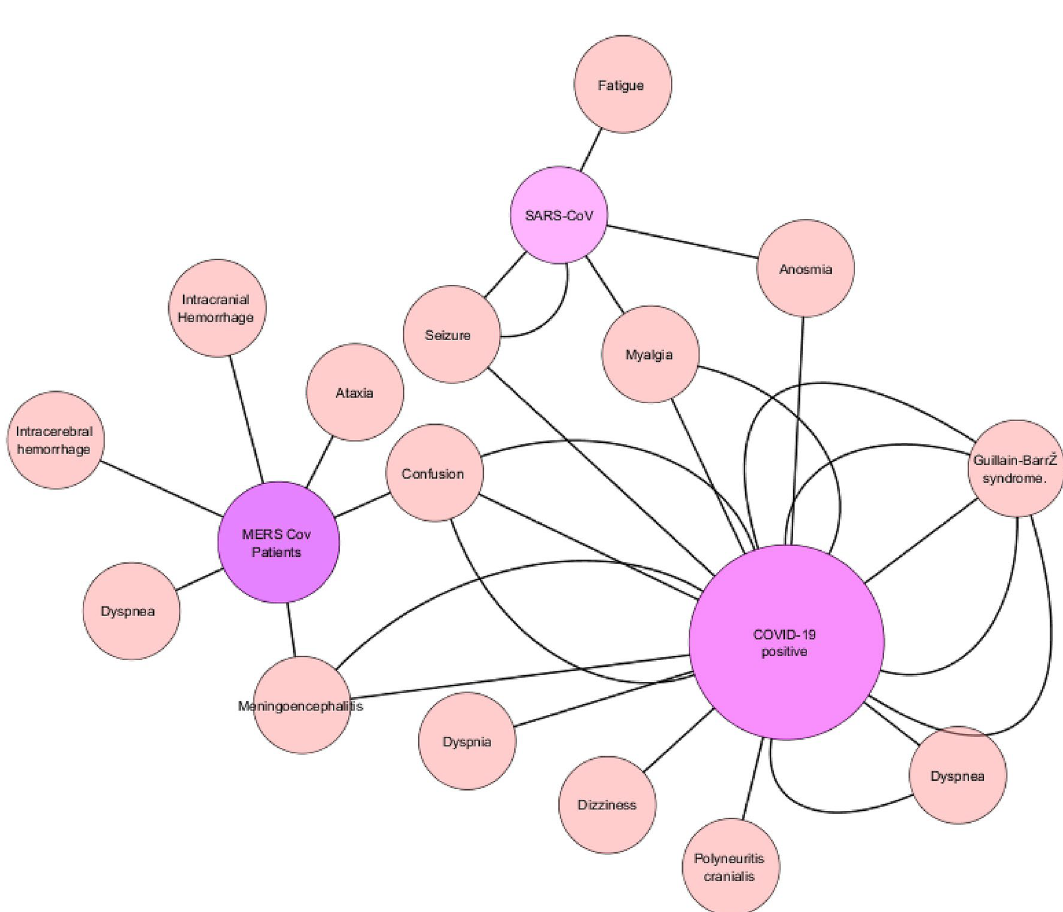
Figure 12. Network analysis showed the impact of neurological manifestation as per described symptoms in case report as well as observational studies. Note : The size of node defines the degree of relation with the individual neurological symptoms and increased number of edges give the increased relation with the respective nodes. (Edges showing directed association, Node size depicts degree of